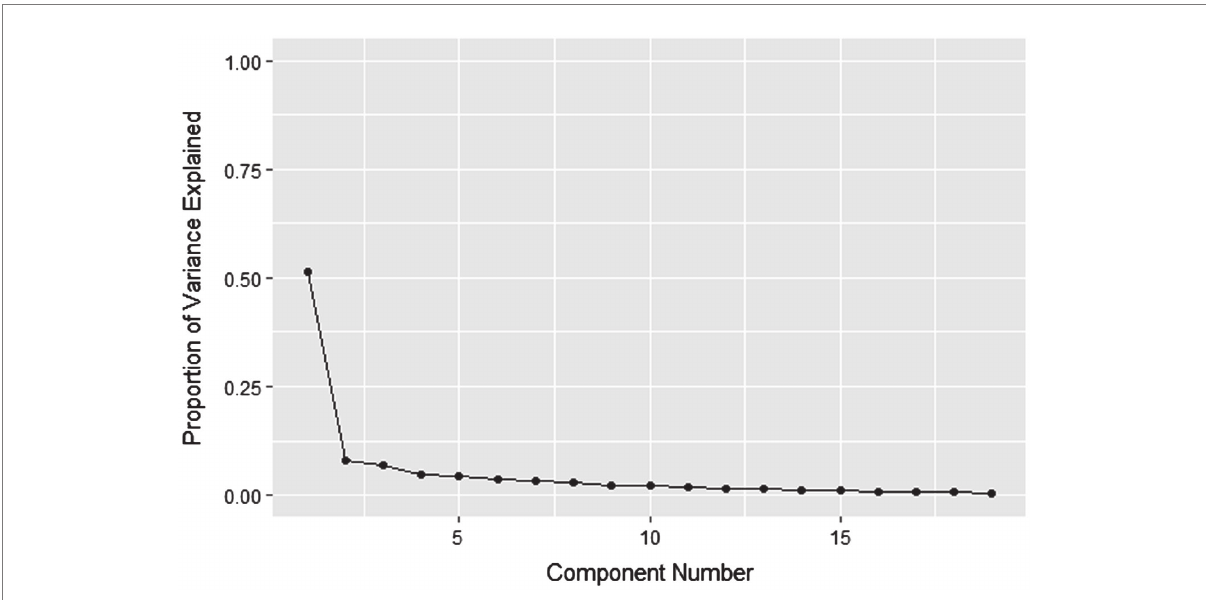
FIGURE 1 Exploratory factor analysis of the RRS with Wave 1 participants. This scree-plot provides a visual representation of the compelling evidence for a single-factor solution found in the EFA with Wave 1